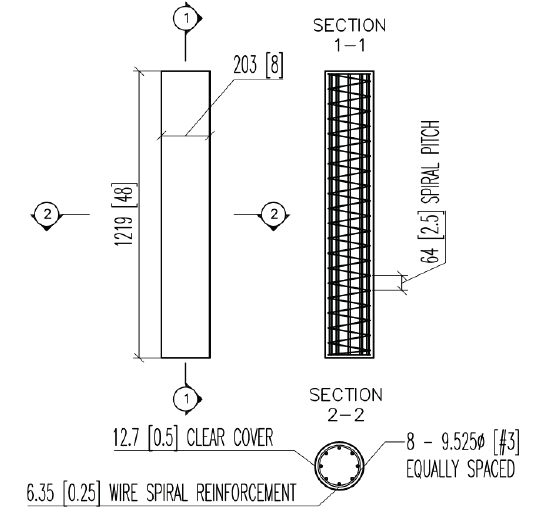
Figure 3. Reinforced concrete (RC) Column Design Drawing.